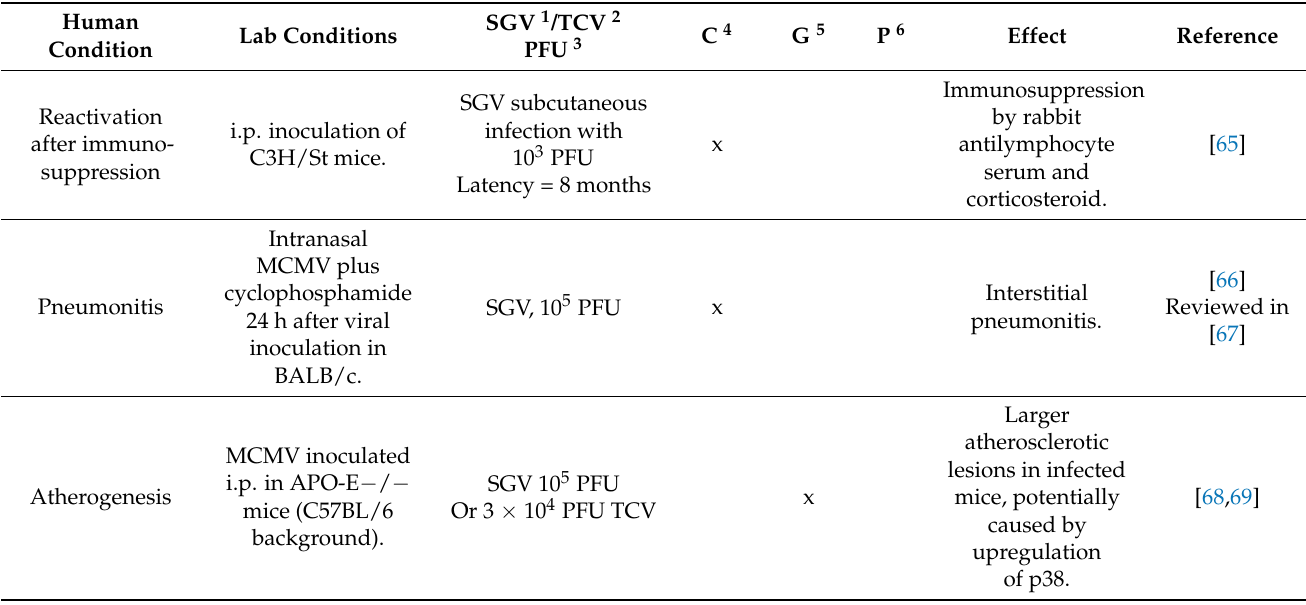
Table 2. Models for CMV disease, requiring significant laboratory